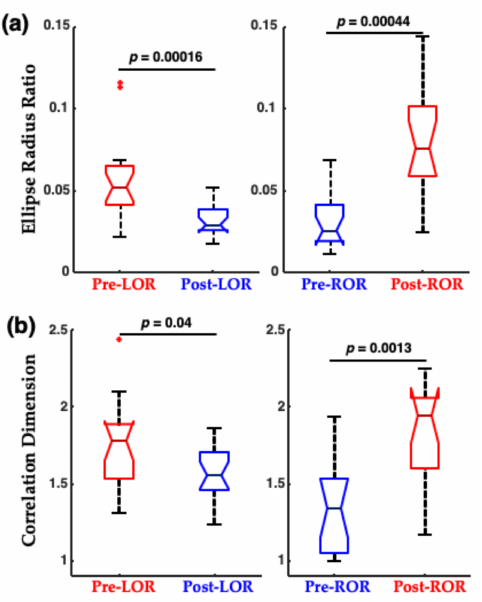
Figure 7. Attractor measures before and after LOR and ROR in patients exposed to propofol anesthe- sia. ( a ) Geometric phase–space analysis (ellipse radius ratio) significantly differs from before to after LOR, and before to after ROR. ( b ) Correlation dimension significantly differs from before to after ROR, and decreases (although not significantly in our sample) from before to after LOR. The p -values shown here are uncorrected. Adapted with permission from Reference [7].